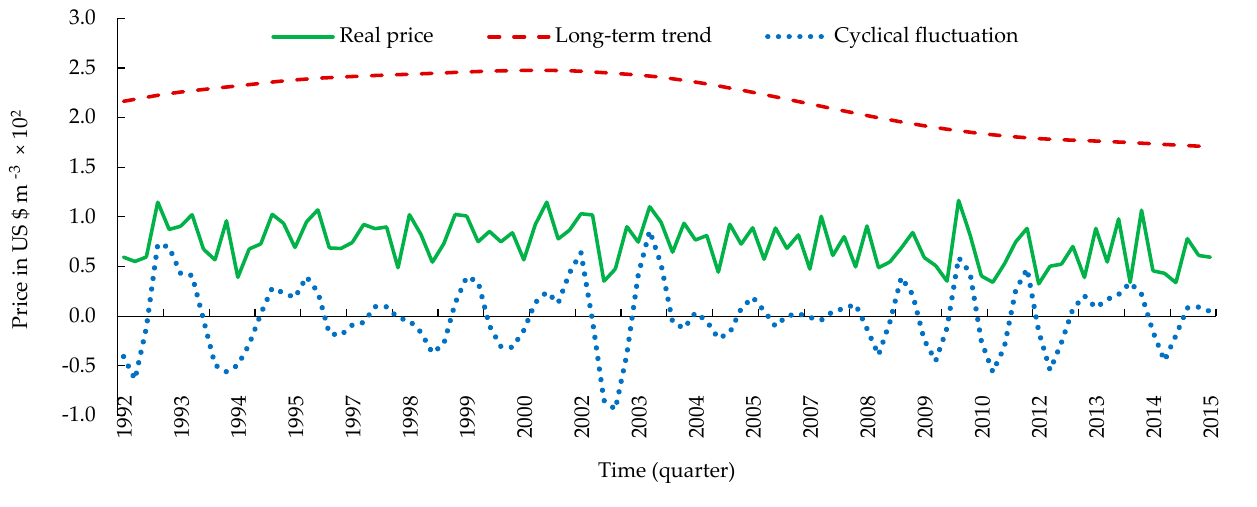
Figure 4. Decomposition of time series of lumber price, including real price as well as long-term trend and cyclical fluctuation in Hyrcanian forest in 1992–2015.